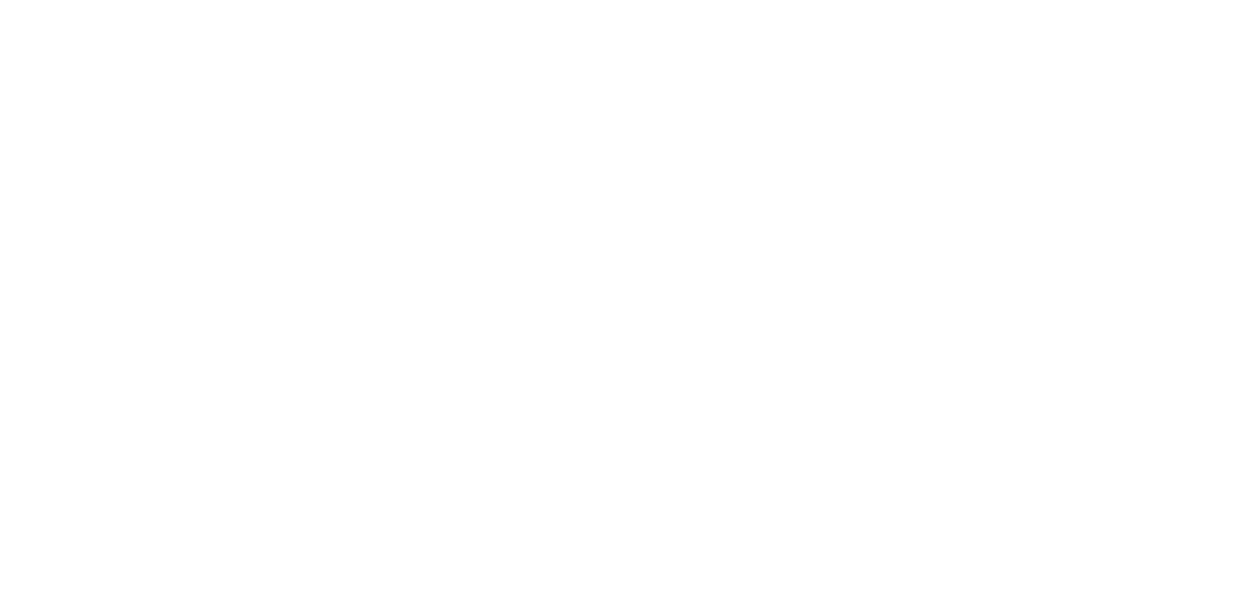
Frontiers in Neuroanatomy | www.frontiersin.org